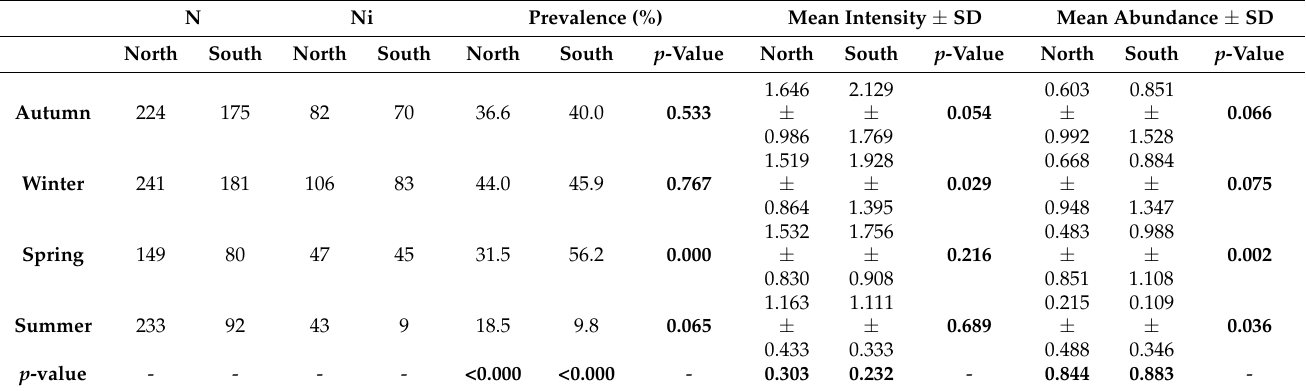
Table 3. Overall parasitic parameters during the annual season for sardines from the northern Catalan Coast and the southern Catalan Coast: N, number of sardines analysed; Ni, number of sardines infected by nematode parasites; Prevalence (%); Mean intensity ± SD; Mean abundance ± SD.